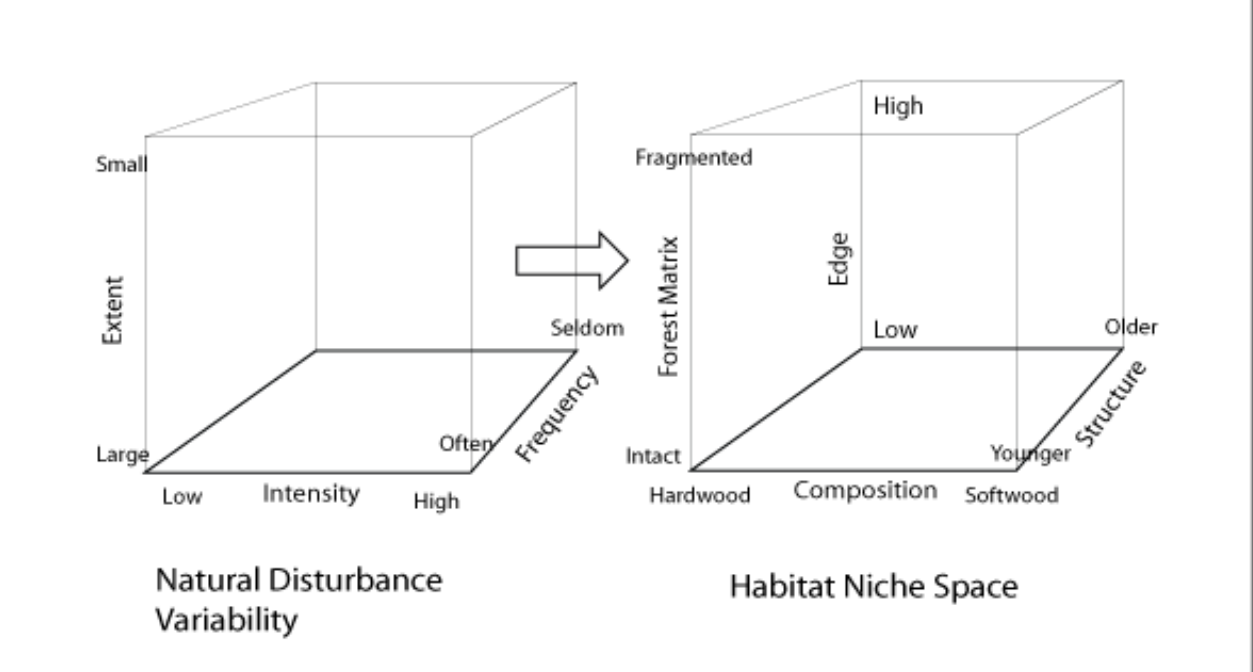
Fig. 1. Translation of variability in extent, intensity, and frequency of natural disturbance to habitat niche-space dimensions of patch interspersion, overstory composition, and stand